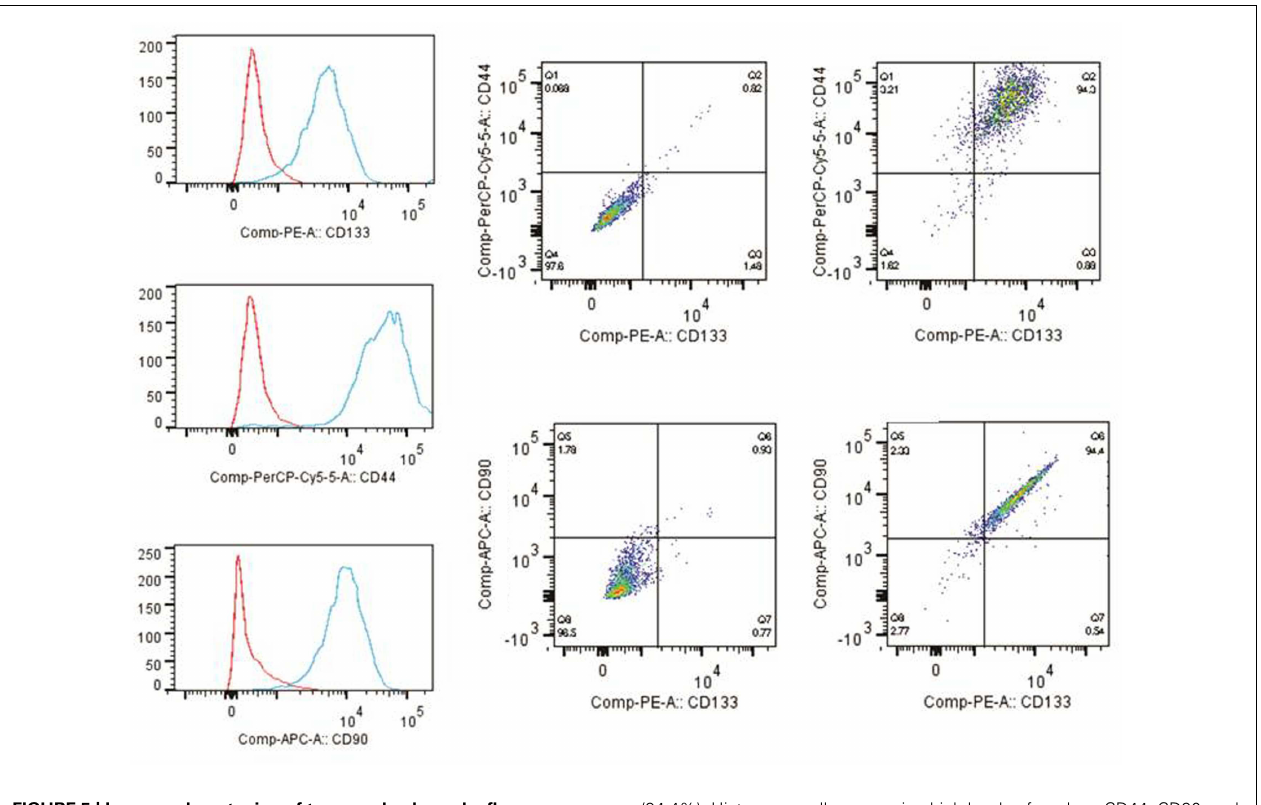
FIGURE 5 | Immunophenotyping of tumor subspheres by flow cytometry .The immunophenotypic profile of CD133 + cells showed that these cells also expressed high levels of markers CD44 (94.0%) and CD90